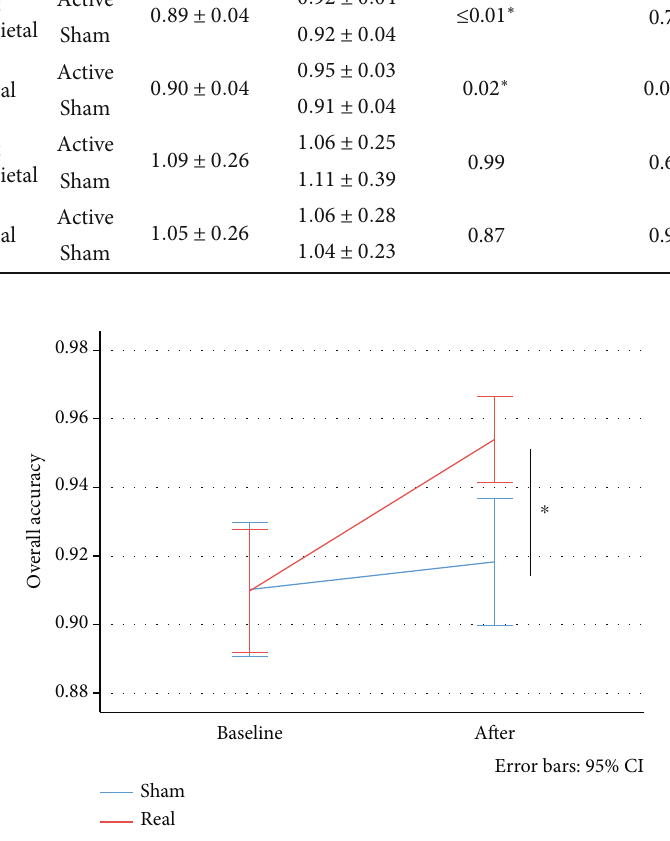
Figure 6: Changes in overall accuracy (in percentage) after bifrontal tDCS montage.